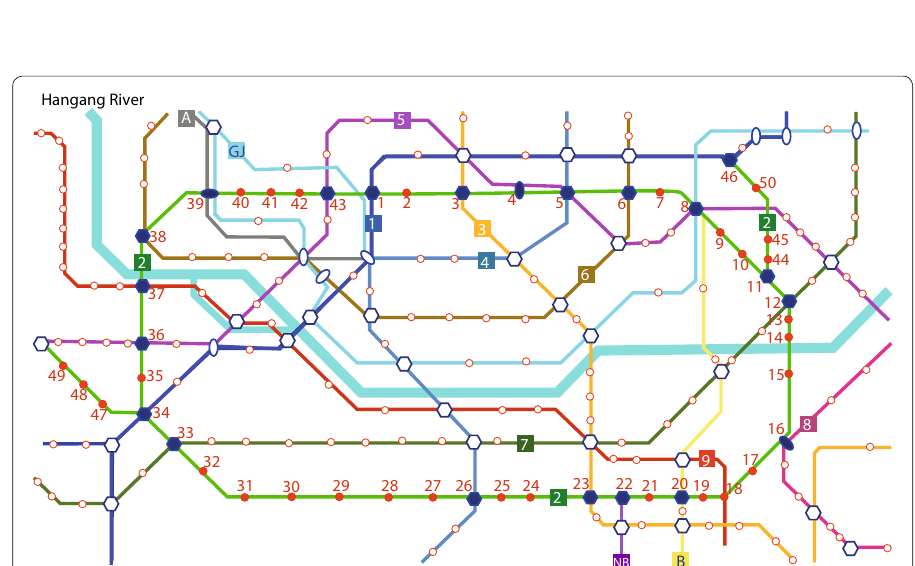
Fig. 2 Sketch of the nine subway lines in Seoul. The oval and hexagonal symbols denote subway transfer sta‑ tions and circle symbols represent regular stations. The filled symbols apply to subway Line #2 (Green Line). The numbers in red denote station numbers for subway Line